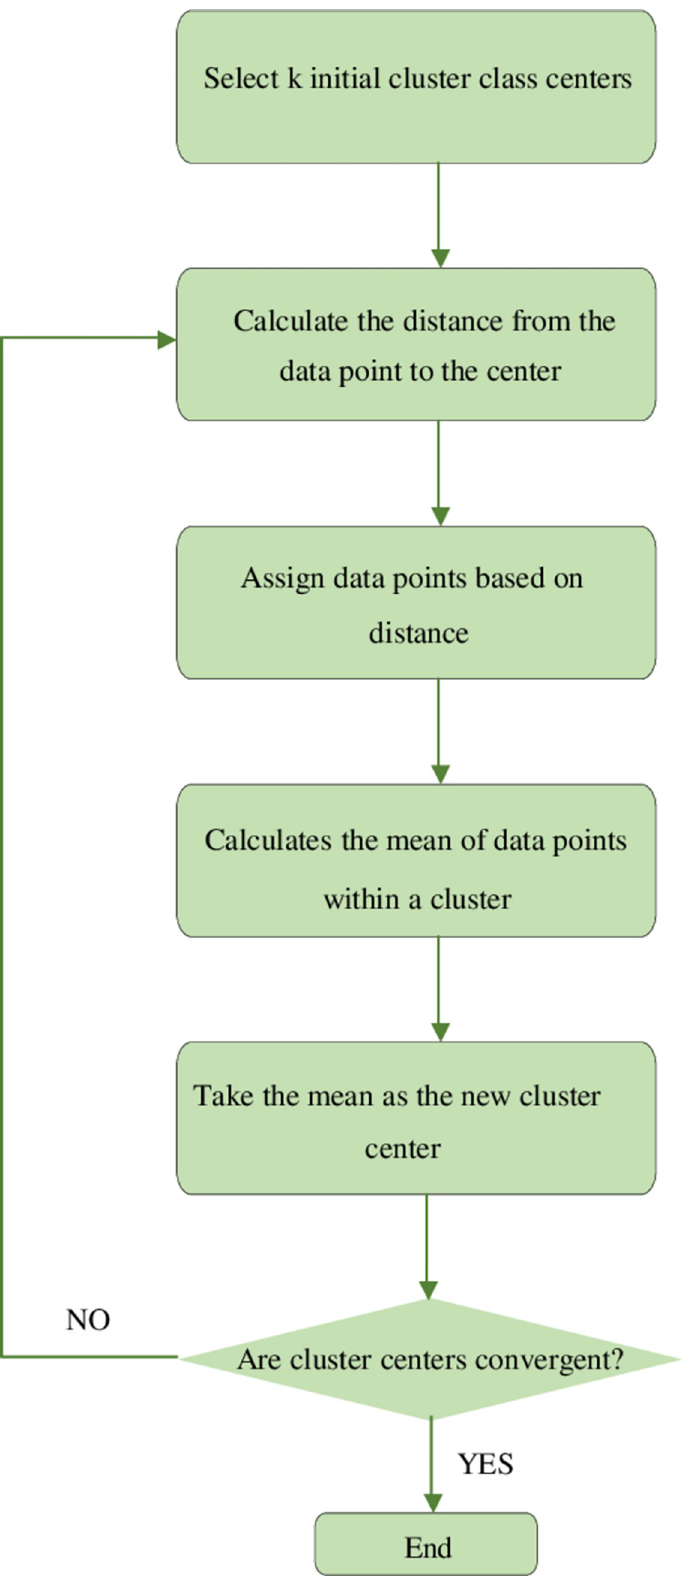
Fig 2. Flowchart of KMC